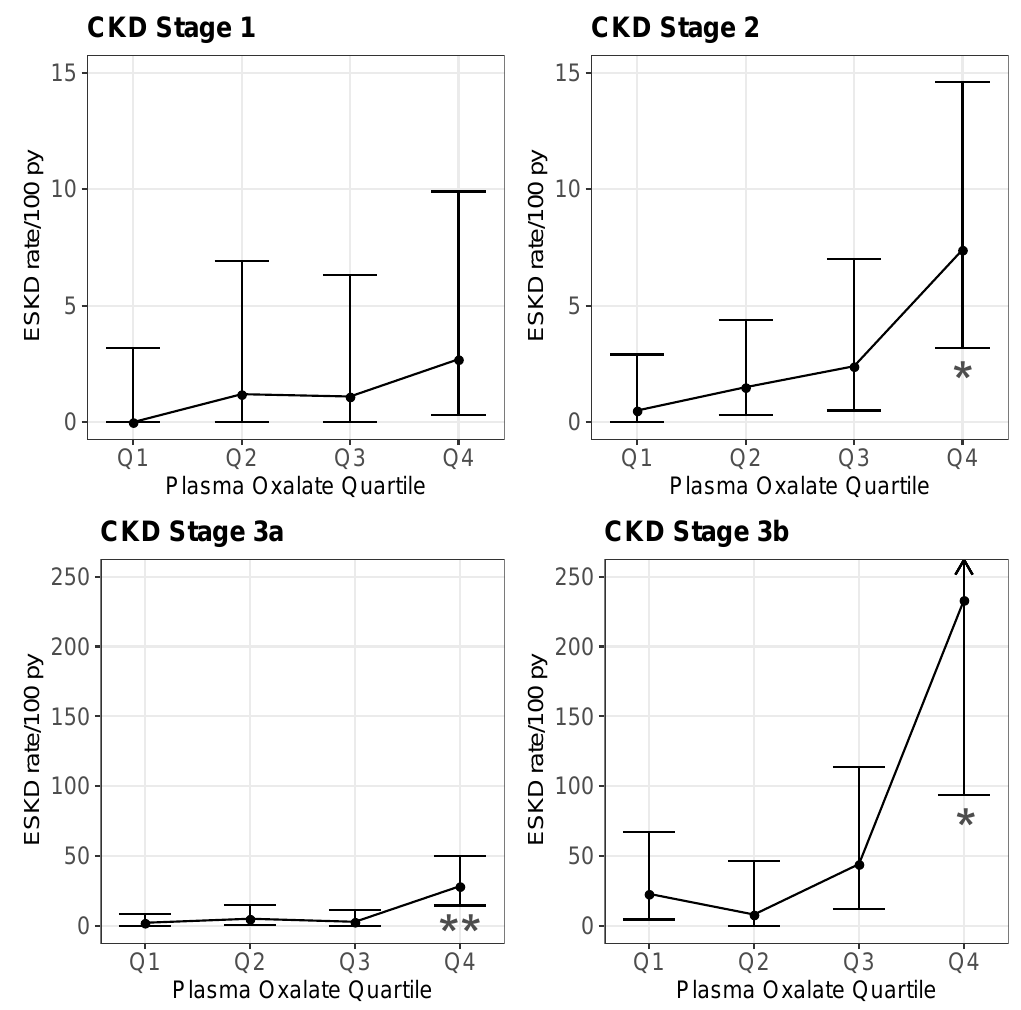
Figure 2. ESKD rate by POx quartile during follow-up by CKD stage. ESKD rates were estimated for each CKD stage group by dividing individual patient follow-up times into intervals based on the time between the POx measures or last follow-up. Person-time and ESKD events were summed within POx quartiles with the rate = [100 × (events / person-time)]; error bars represent 95% CI of the ESKD rate (see Supplemental Table S1 for numerical values). ESKD rates were similar for the lower three quartiles (Q) but increased for the highest POx quartile across CKD stages 2–3b (Q4 vs. Q1 HR 14.21; 95% CI 1.76–114.7; * p < 0.05 for CKD stage 2, HR 13.66; 95% CI 3.02–61.91; ** p < 0.001 for CKD stage 3a, and HR 5.19; 95% CI 1.10–24.5; * p < 0.05 for CKD stage